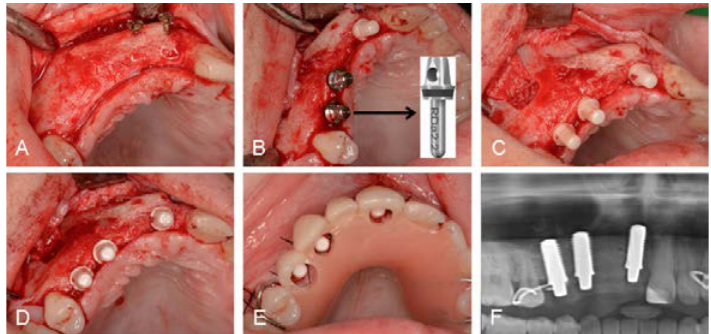
Figure 7. ( A ) Clinical situation after elevation of mucoperiostal flap; ( B ) control of implant positions with implant position indicators; ( C , D ) final implant positions, implant in region of 14 was placed in combination with a simultaneous sinus floor elevation; ( E ) adapted occlusally stabilized temporary porsthesis; and ( F ) panoramic radiographic investigation immediately after implant placement. Surgeon: Dr. Stefan Roehling.